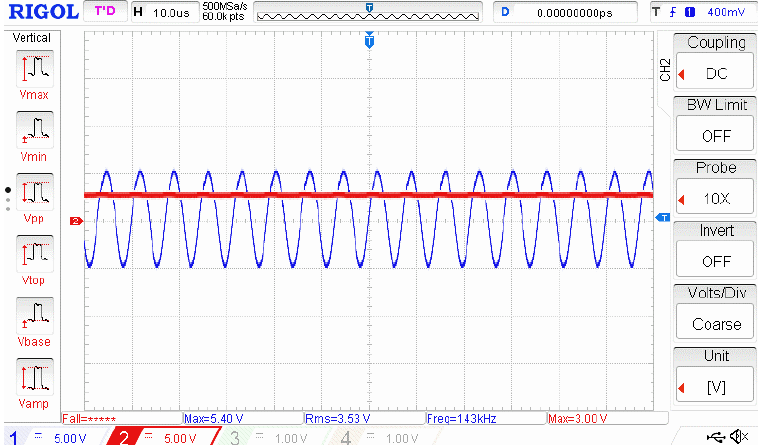
Figure 14. Peak detector output voltage; blue curve (CH_1) shows the main signal waveform, red curve (CH_2) presents the measured voltage of the passive peak voltage sensor.